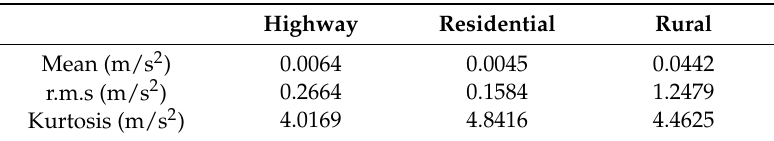
Figure 5. Measured strain time histories from different road conditions: ( a ) highway; ( b ) residential; and, ( c ) rural. Table 4. Statistical analysis of acceleration